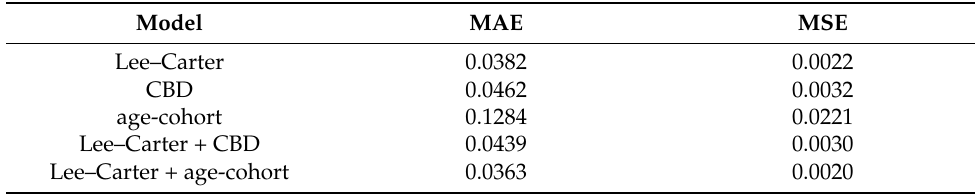
Table 1. Mean absolute errors (MAE) and mean square errors (MSE) of projected log death rates over 2000–2017 under different Bayesian models.